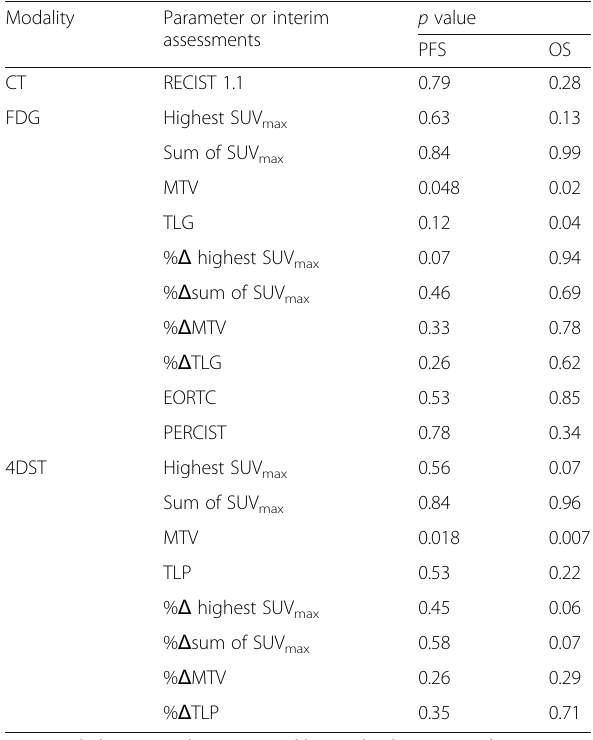
Table 5 Kaplan-Meier estimates and log-rank tests for PFS and OS in FDG and 4DST parameters